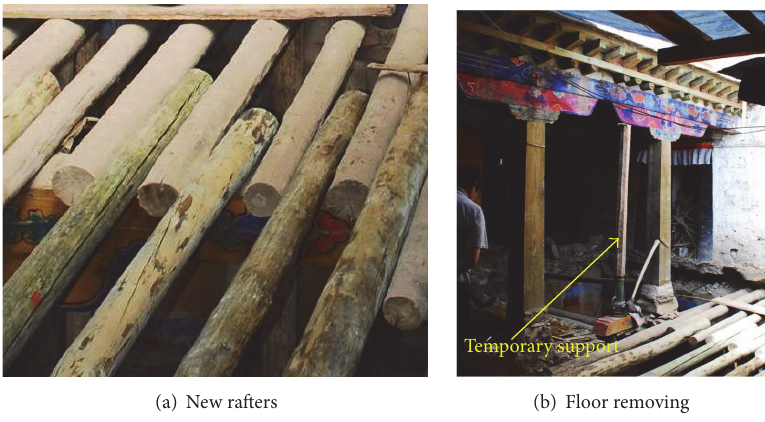
Figure 22: Rehabilitation of corrupted